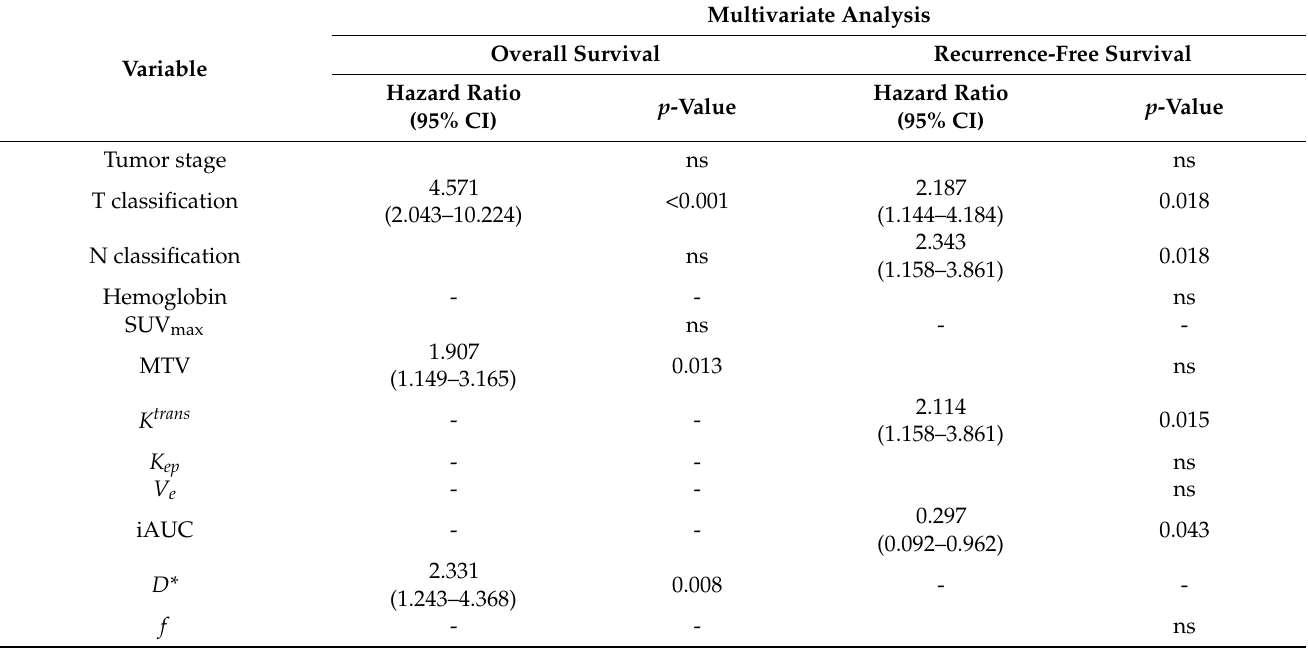
Table 4. Multivariable analysis of clinical risk factors and PET/MRI biological imaging markers